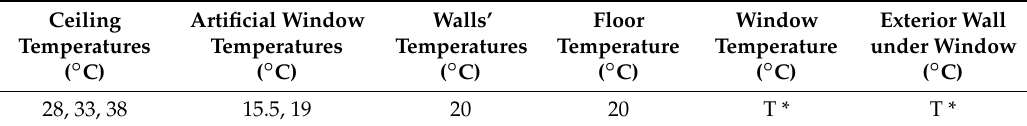
Table 1. Boundary conditions: set temperatures at inner surfaces.